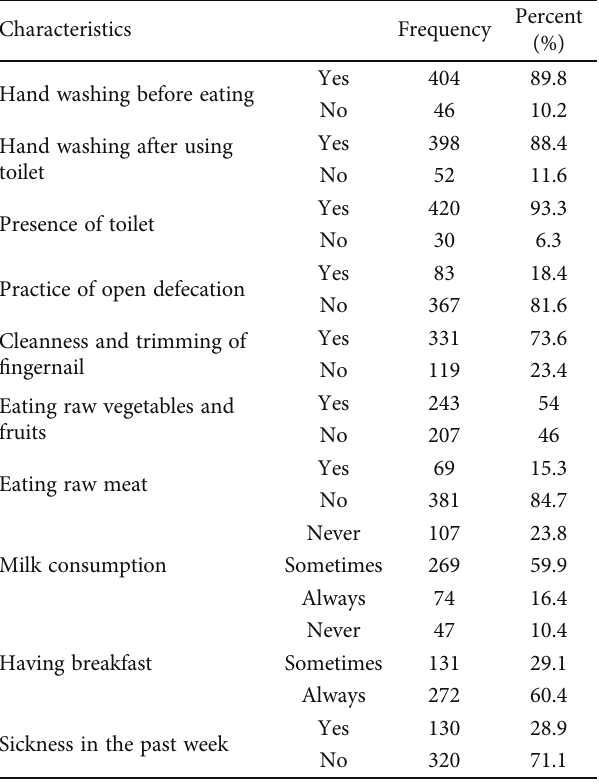
Table 2: Hygienic practice and food habits of the study participant in Dessie town, North-central Ethiopia, 2021.